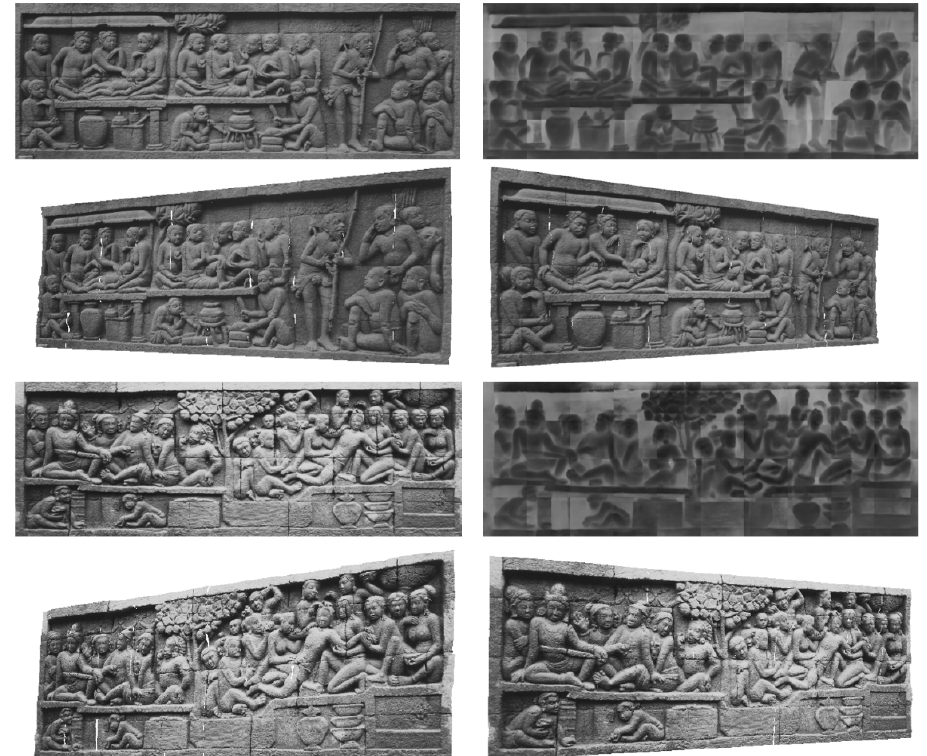
Figure 17. Depth estimation and reconstruction results from two examples: The top four pictures and the bottom four pictures represent the results of two old photos, respectively. From top right to bottom left in each group: the old monocular photo, the depth estimation result, and the screenshot of the 3D reconstructed points from the left and right sides, respectively.